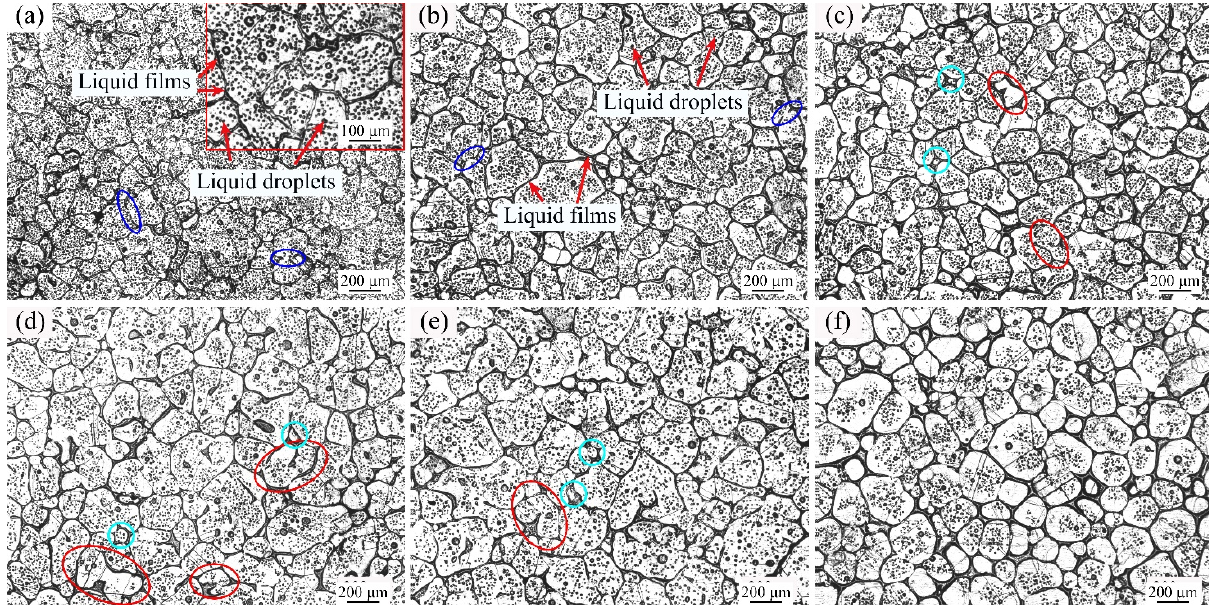
Figure 3. Optical micrographs of GH3536 alloy heat treated at 1350 °C for ( a ) 5 min, ( b ) 15 min, ( c ) 30 min, ( d ) 60 min, ( e ) 90 min, and ( f ) 120 min.